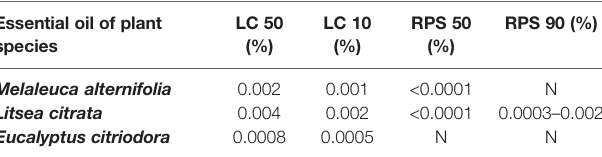
TABLE 2 | A summary table with EOs ’ lethal concentrations to 50% (LC50) value, 10% (LC10) value, and the EOs ’ concentration of relative precent of survival 50% (RPS 50) and 90% (RPS 90) of Artemia .